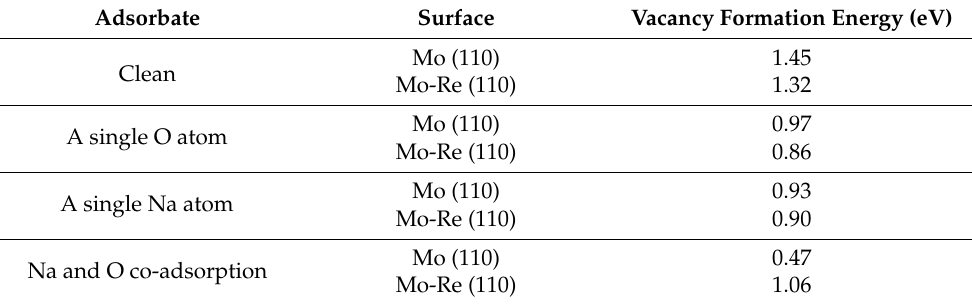
Table 5. Mo vacancy formation energy on different surface